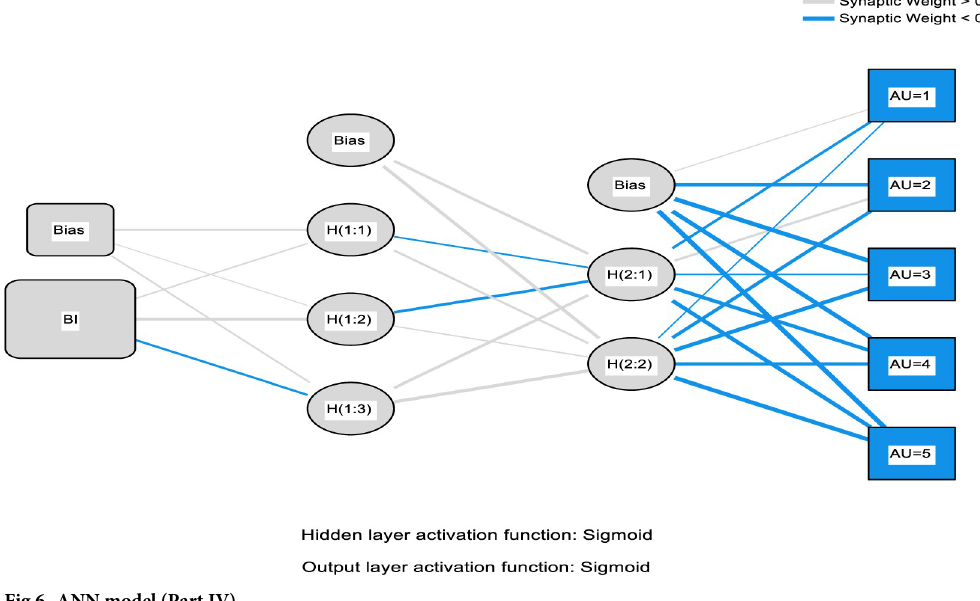
Fig 6. ANN model (Part IV).